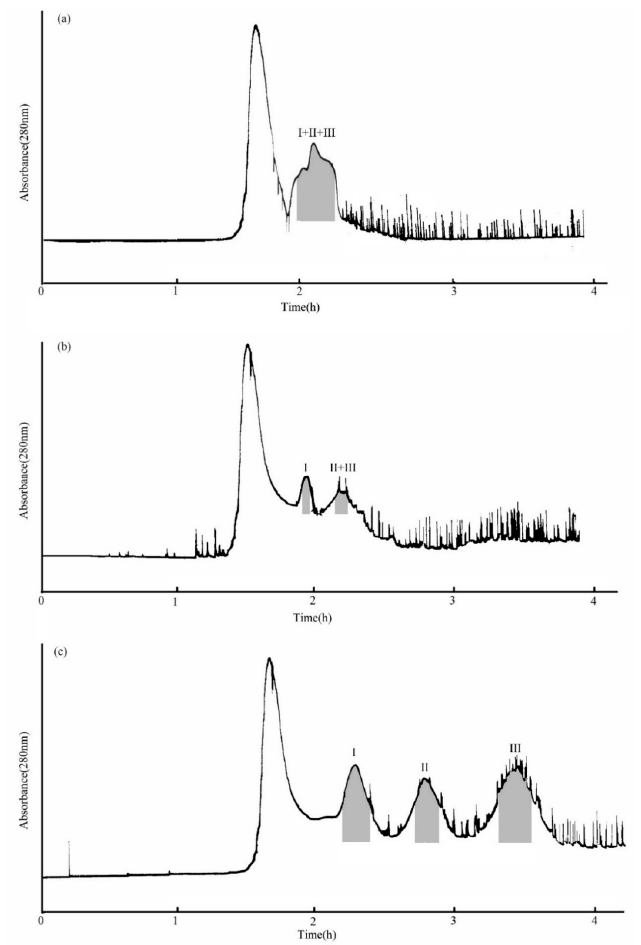
Figure 3. HSCCC chromatogram of the crude sample from PLBs of D. officinale. ( a ) MTBE-n-butyl alcohol-acetonitrile- water (4:2:3:8, v/v/v/v ) system, retention of stationary phase: 36.7%, flow rate: 2.0 mL/min; ( b ) MTBE-n-butyl alcohol-ace- tonitrile-water (5:1:2:6, v/v/v/v ) system, retention of stationary phase: 35.9%, flow rate: 2.0 mL/min; ( c ) MTBE-n-butyl alco- hol-acetonitrile-water (5:1:2:6, v/v/v/v ) system, retention of stationary phase: 41.67%, flow rate: 1.0 mL/min. Peak Ι : β -D- glucopyranose 1-[(E)-3-(4-hydroxyphenyl)-2-propenoat], Peak ΙΙ : β -D-glucopyranose 1-[(E)-3-(3,4-dihydroxyphenyl)-2- propenoat], Peak ΙΙΙ : 1-O-sinapoyl glucopyranoside.